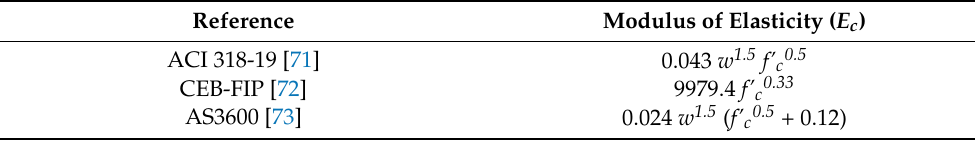
Table 8. Equations relating the modulus of elasticity to the cylinder compressive